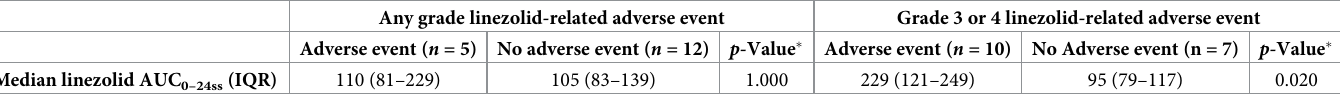
Table 6. Comparison of median linezolid AUC 0–24ss by occurrence of linezolid-related adverse events in children with MDR-TB ( n = 17). Any grade linezolid-related adverse event Grade 3 or 4 linezolid-related adverse